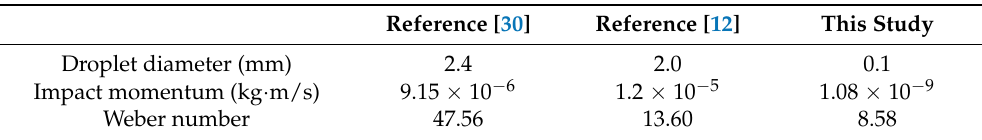
Table 1. The comparison of the currently defined parameters droplet diameter, impact momentum, and Weber number with typical